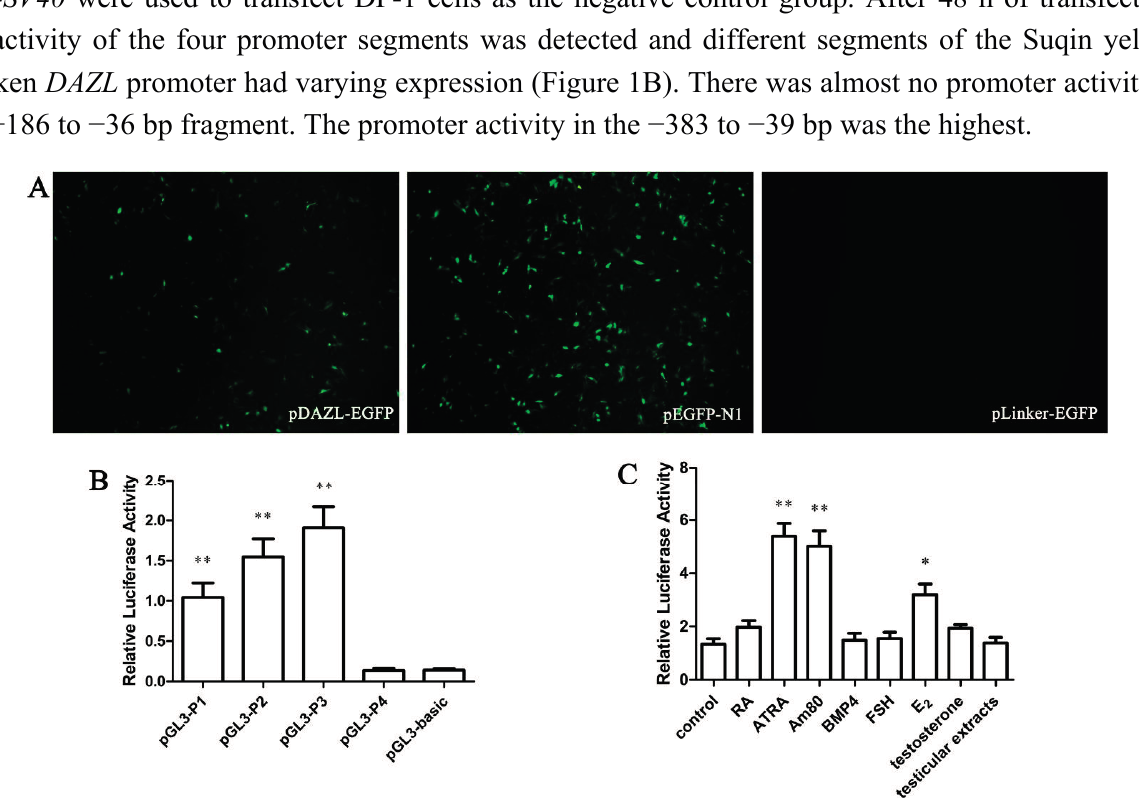
Figure 1. ( A ) The green fluorescent protein (GFP) detection of promoter activity of